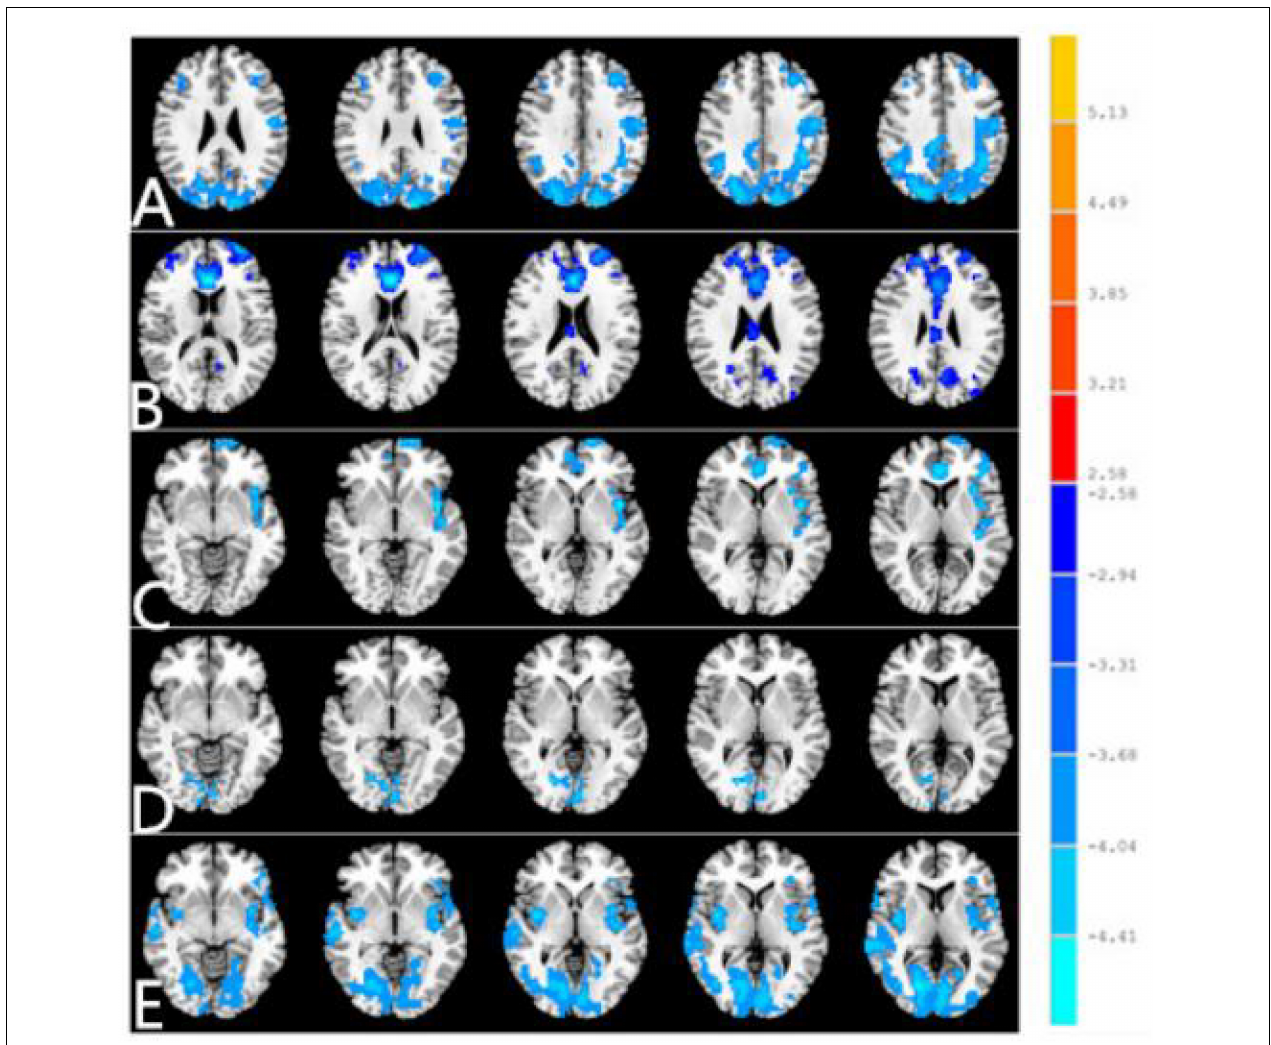
FIGURE 3 | Different FC between two groups with region of interest (ROI) in R_CER_8 (A) . Different functional connectivity (FC) between two groups with ROI in L_CER_4-5 (B) . Different FC between two groups with ROI in R_CER_8. (C) Different FC between two groups with ROI in B_LING/CAL/SOG (D) . Different FC between two groups with ROI in R_PostCG (E) . The red denotes higher FC signal values, and the blue areas indicate lower FC signal values (voxel-level p < 0.01, GRF correction, cluster-level p < 0.01). FC, functional connectivity; PACG, primary angle-closure glaucoma; HC, healthy control; CER, cerebellum; LING, lingual gyrus; CAL, calcarine; SOG, superior occipital gyrus; PostCG, postcentral